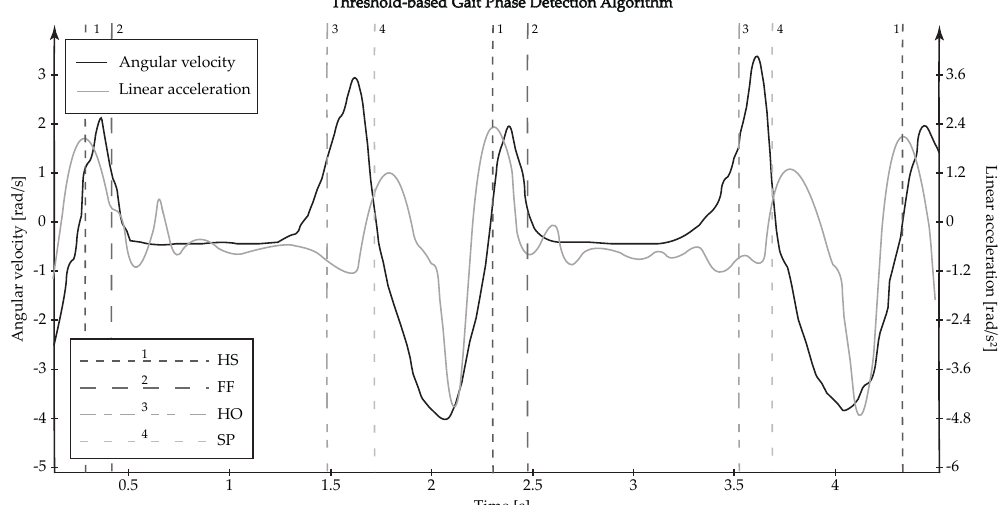
Figure 2. Threshold-based gait phase detection by means of an inertial sensing system over two gait cycles. Feature-based decisions are made to identify each gait phase start: HS (first dashed line), FF (second dashed line), HO (third dashed line) and SP (fourth dashed line).